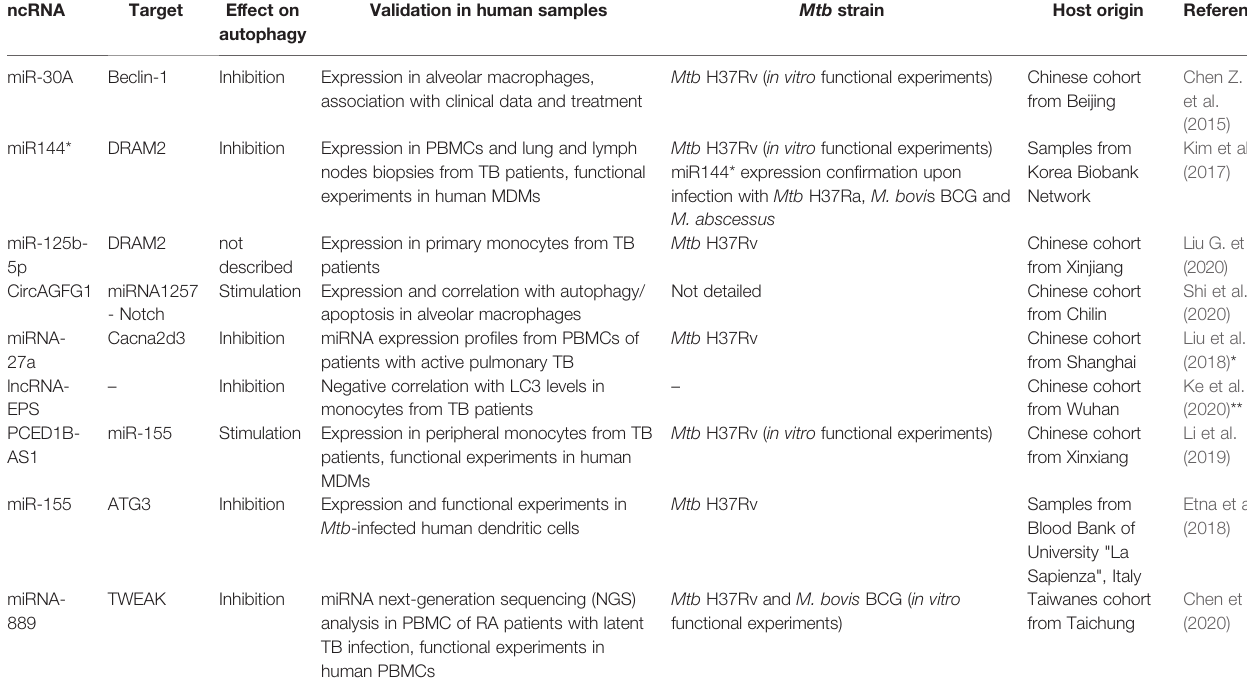
TABLE 2 | Non-coding RNAs in fl uence autophagy outcome during human